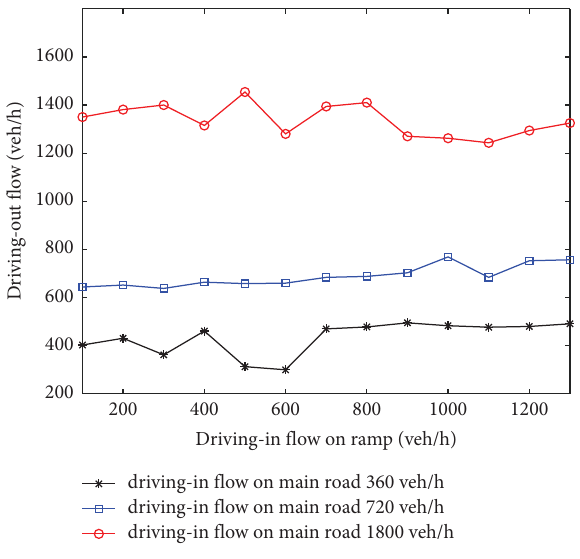
Figure 11: Infuence of ramp input fow.